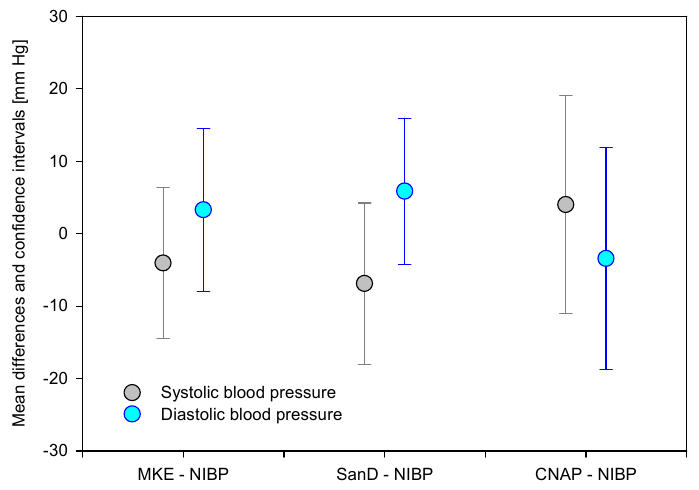
Figure 5. Comparison of the differences (test–ref) in blood pressure as mean ± confidence intervals for MKE, SanD and CNAP and related to the systolic and diastolic blood pressure.